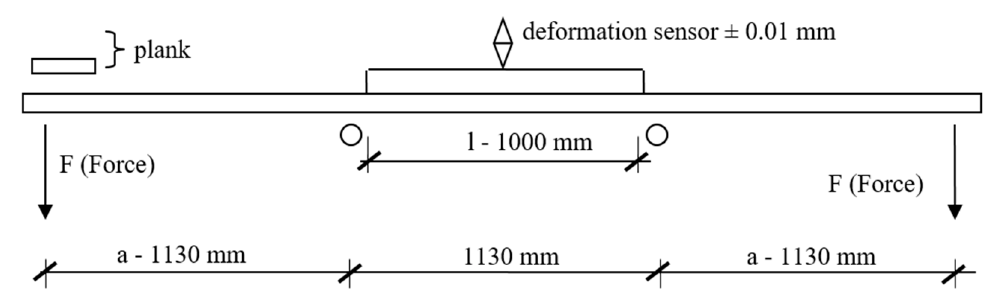
Figure 1. The experimental setup used to identify MOE parameter.